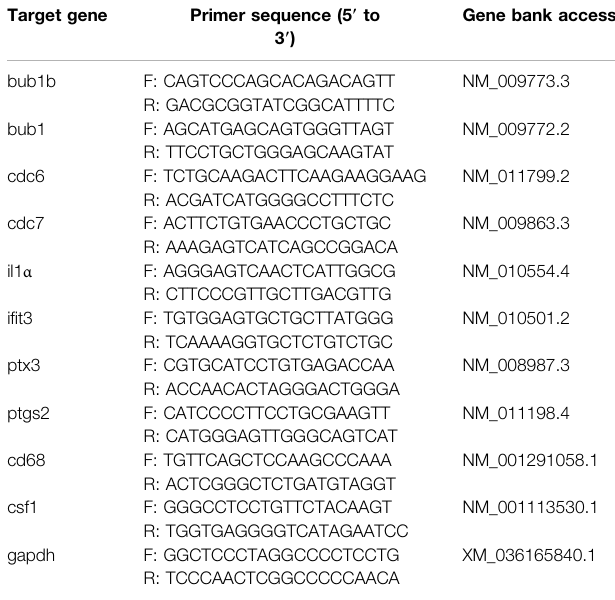
TABLE 1 | Sequence of primers used in